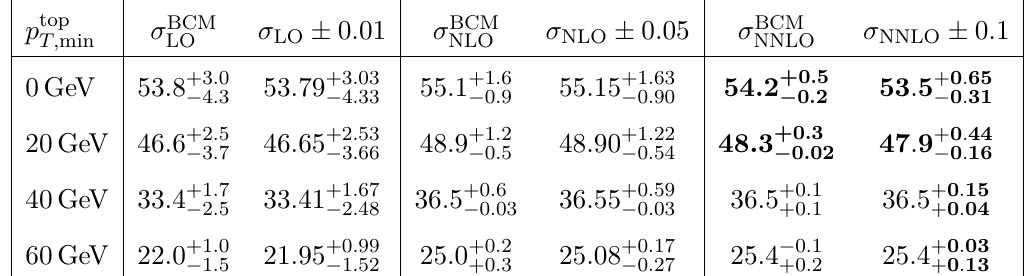
Table 2 . Comparison with fully inclusive top-quark production results from Brucherseifer, Caola, Melnikov in ref. [36]. Cross-sections in picobarns. Scale uncertainties in super- and subscript are from simultaneous variation of µ R = µ F = m t by a factor of two and one half,